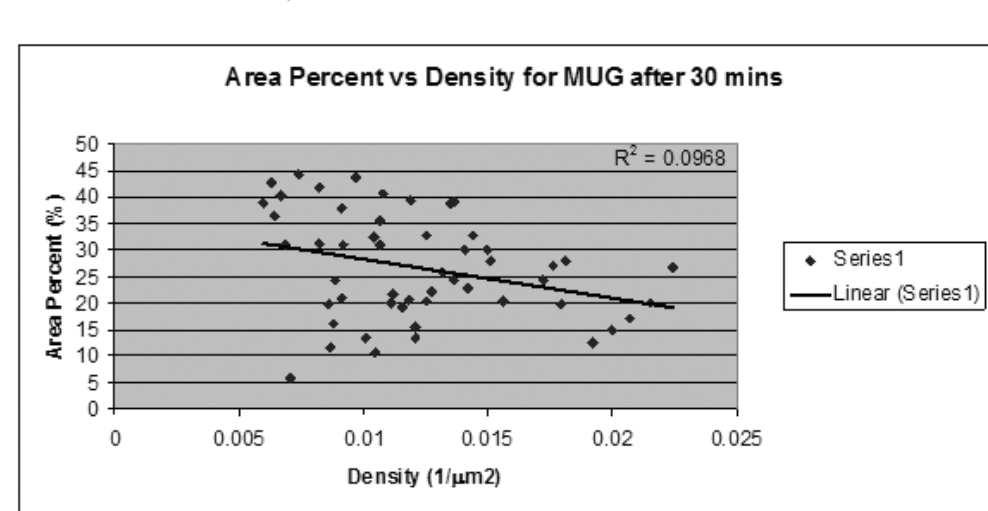
Figure 13: Area Percent vs. Density of wear for MUG after 30